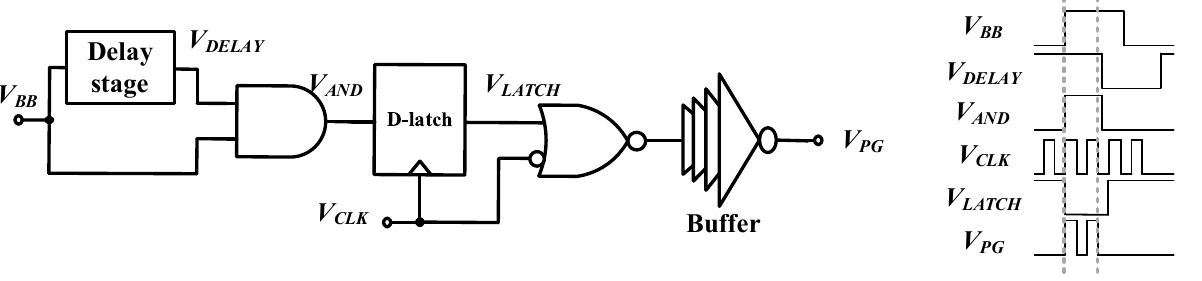
Figure 5. Block diagram and timing diagram of the pulse generator.